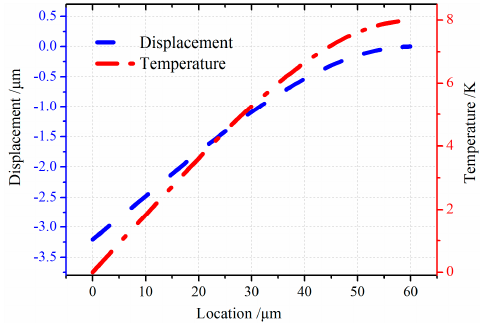
Figure 11. The temperature variation and displacement distribution for transverse vibration: ( a ) temperature variation; ( b ) displacement distribution.